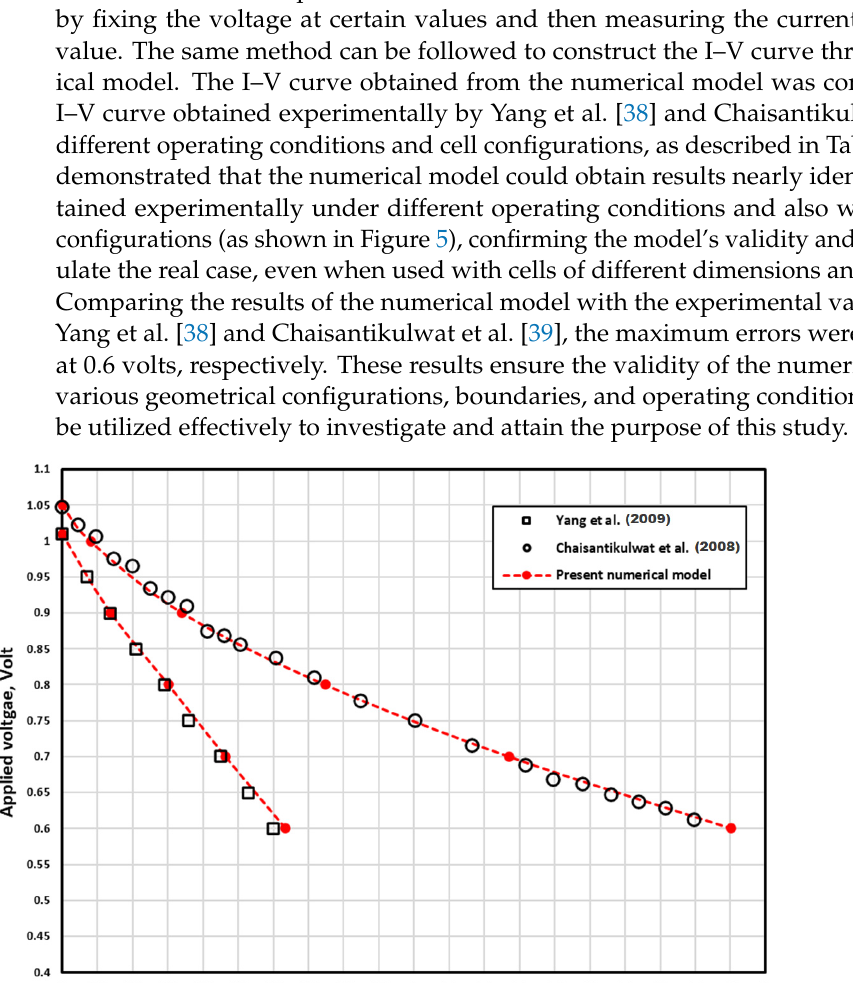
Table 5. The operating conditions for the various experimental studies used for model validation.